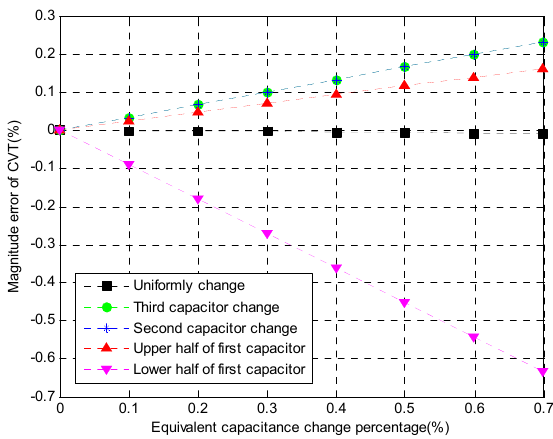
Figure 12. CVT magnitude error with different equivalent capacitance.